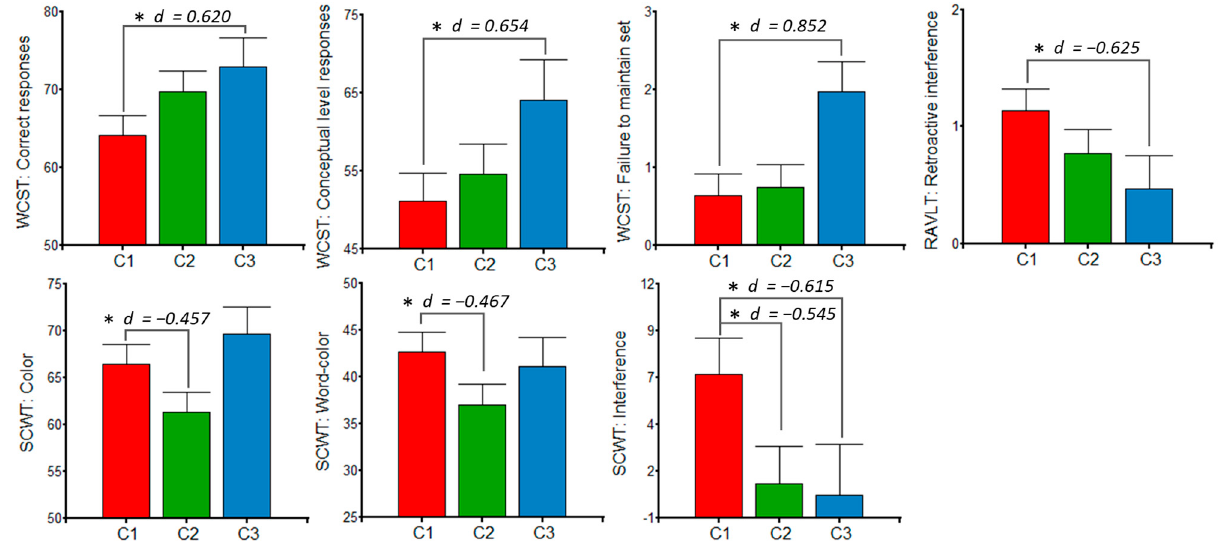
Figure 6. Postpartum women’s performance in the Wisconsin Card Sorting Test (WCST), Rey Auditory Verbal Learning Test (RAVLT), and Stroop Color and Word Test (SCWT) according to polyphenolic intake clusters (5 to 20 mg/d). ANCOVA models were adjusted by educational level, postpartum days, parity, dietary indices (macronutritional, phytochemical, and energetic), and insomnia, with a Fisher’s post hoc contrast. C1: n = 33; C2: n = 29; C3: n = 13. d = Cohen’s d for effect size; * p < 0.05.